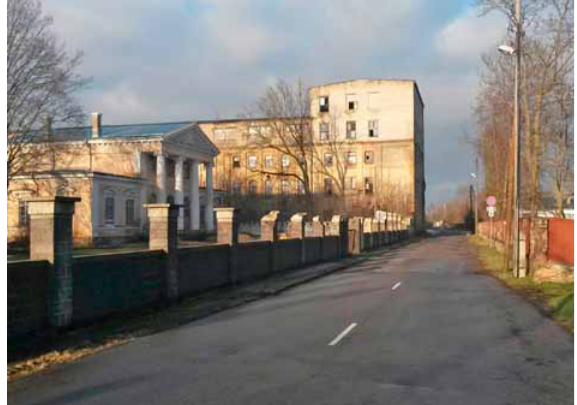
fig. 10. The former flax spinning mill and Villa